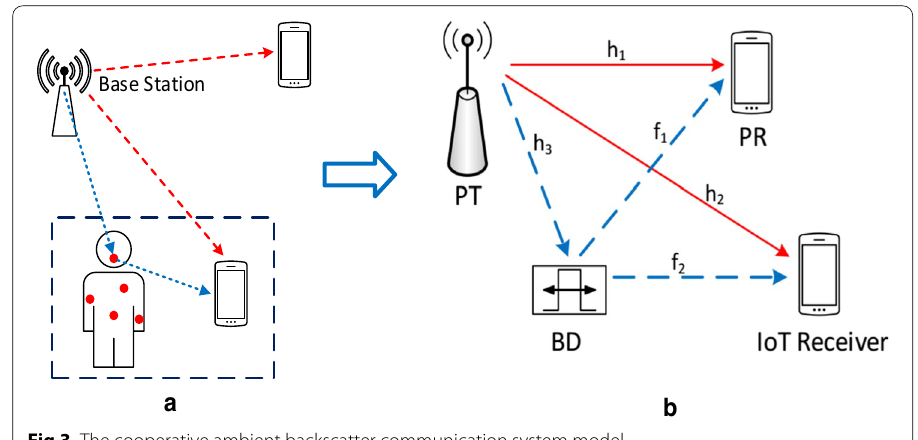
Fig.3 The cooperative ambient backscatter communication system